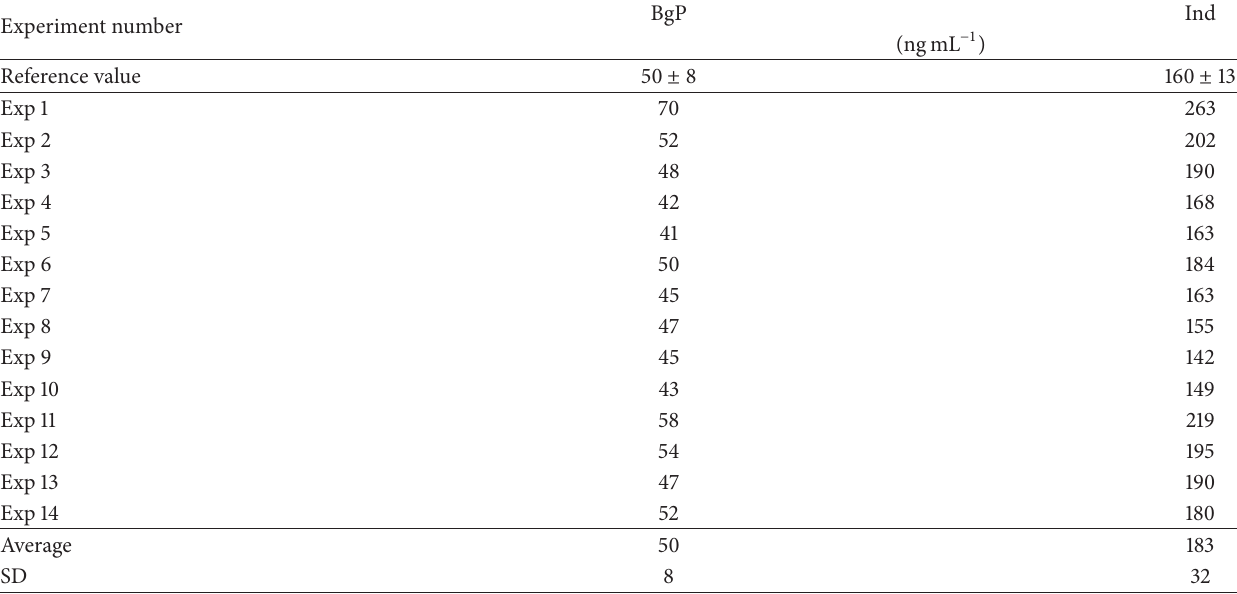
Table 4: Results of measurement test with SRM 1975 diesel particulate matter